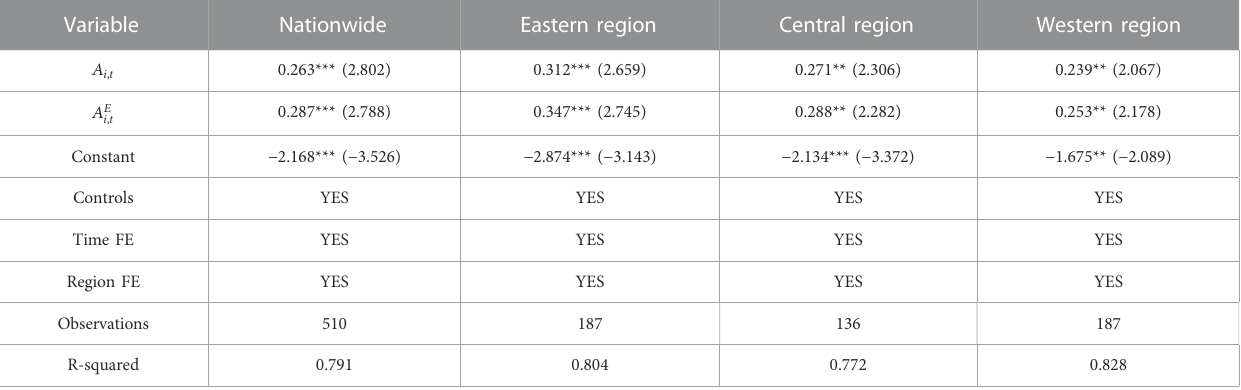
TABLE 10 Regression results after adding omitted